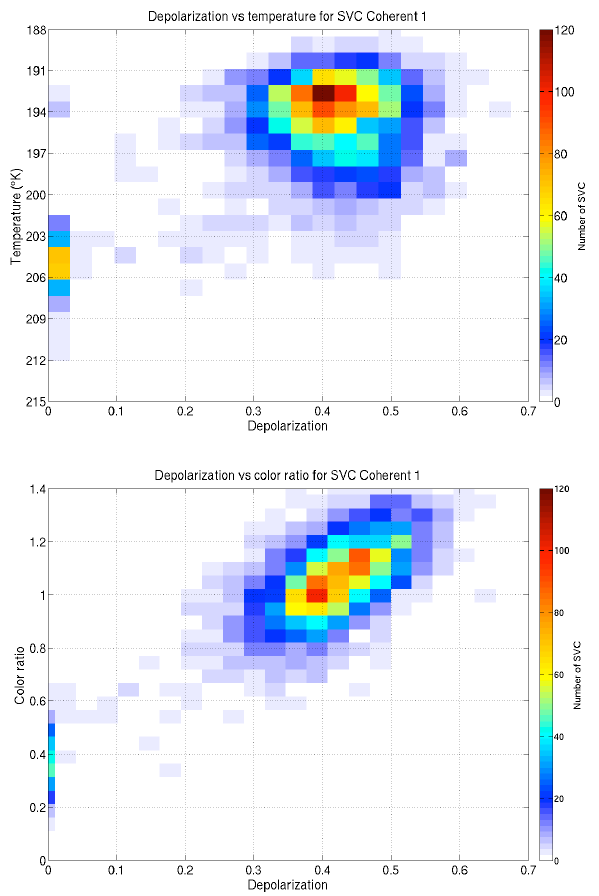
Fig. 8. Distributions of depolarization ratio vs. temperatures (top), and depolarization ratio vs. color ratio (bottom) for all C1 SVC over 15-days in